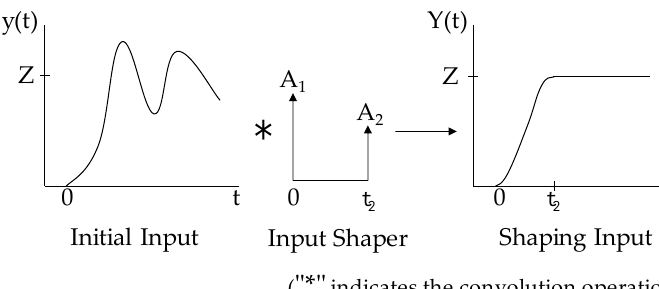
Figure 8. Single-modal input shaping control principle.